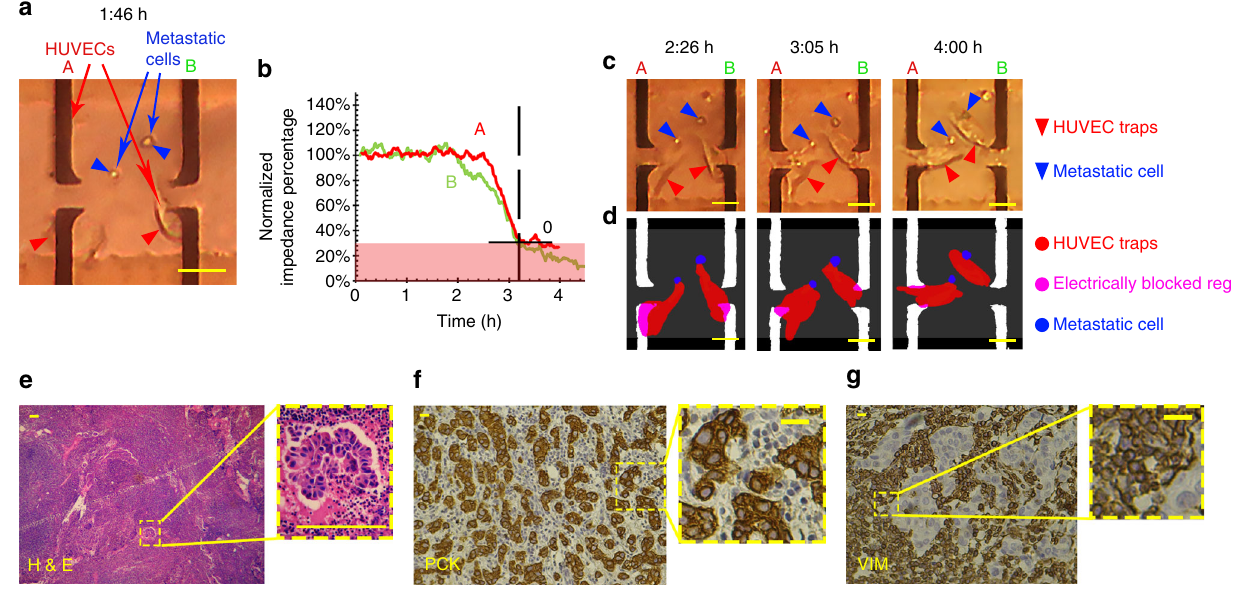
Fig. 3 Capture of metastatic cells in SLN samples of a patient with metastatic cancer by both Metas-Chip and pathological process. a Representative images of two live metastatic cells detached themselves from the isolated lymph of the patient with metastatic breast cancer and attacked two individual single-HUVEC-sensing traps. b Their invasion induced sharp reduction in electrical response of the traps by retracting the HUVECs from the sensing electrodes, which could be traced in time-lapse optical images ( c ) and simultaneous schematics ( d ). H&E and immunohistochemical characterization of the patient ’ s SLN: ( e ) Images of a lymph region stained with hematoxciline and eosine. Nest of tumor cells with hyperchromic nucleus could be observed. This would indicate that the lymph node has been metastasized by invasive ductal breast carcinoma. ( f ) Pan cytokeratins and ( g ) vimentin expression in the sentinel lymph node of the patient with metastatic breast carcinoma. High reactivity of the cells with the markers (brown-yellow faint colors in the images) indicates the sharp involvement of the lymph with tumor cells. The scale bars for a , c , d , f and g are 25 µ m in length and the scale bar for e is 100 μ m